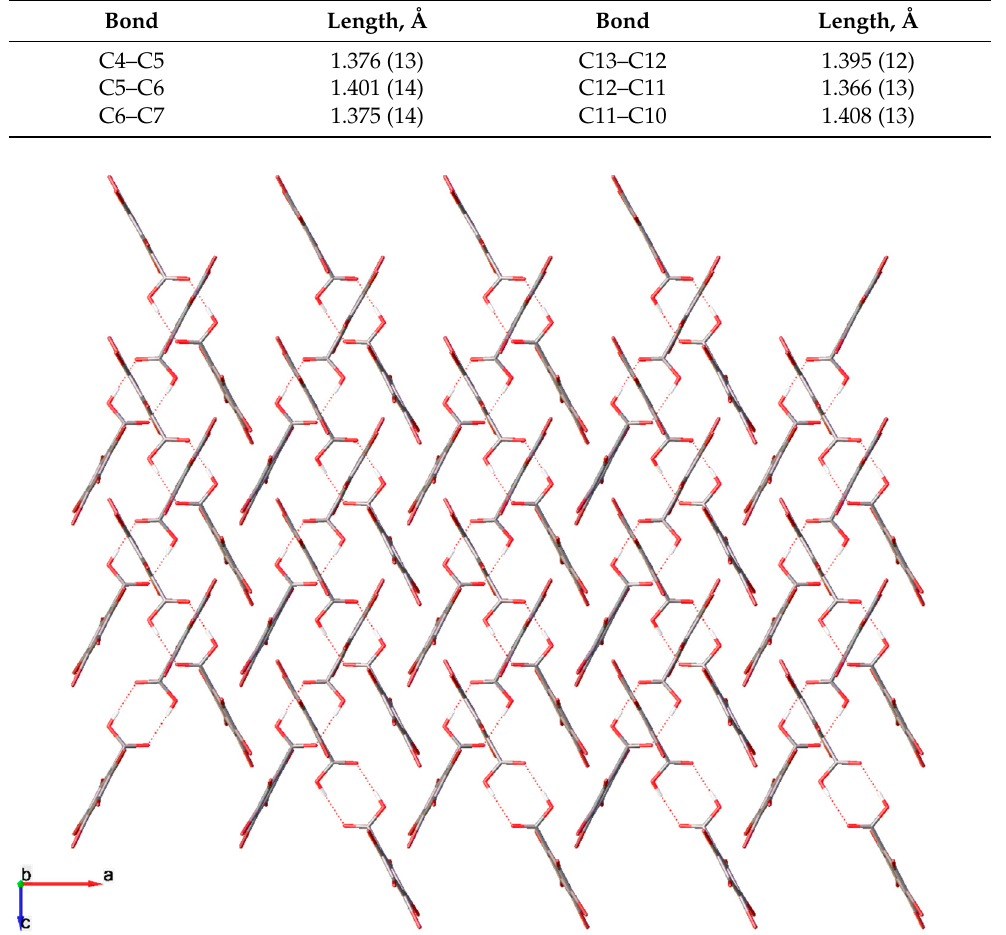
Figure 2. Crystal packing of 1 along (010) plane. Hydrogen O-H...O bonds are illustrated with dotted lines. Table 2. List of hydrogen bonds present in the crystal of 1 and their geometrical parameters.